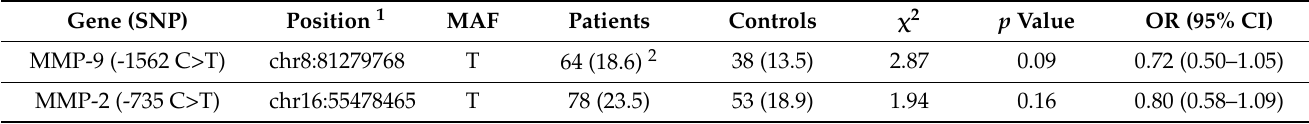
Table 2. Distribution of MMP-9 and MMP-2 alleles in PE cases and control